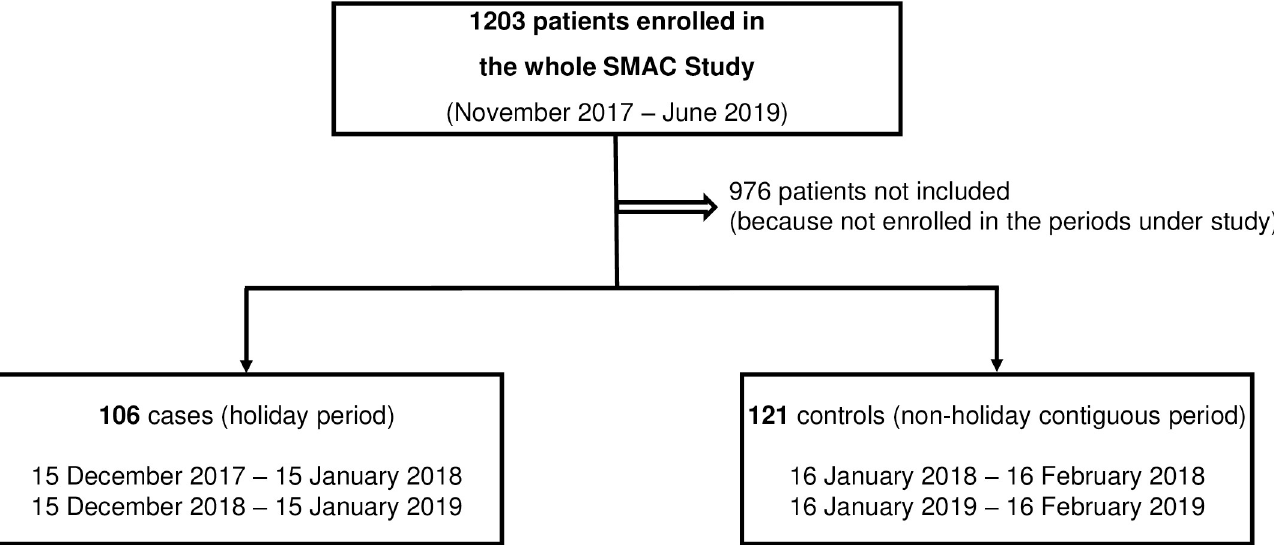
Fig 1. Flowchart of the study. As per protocol designs, two study populations were identified from all patients enrolled in the SMAC study. Patients enrolled in 32 consecutive days during the December holiday period (cases) and 32 consecutive, contiguous days during a non-holiday period (controls) were considered for the purpose of the study. Abbreviations: SMAC, San MAtteo Complexity.